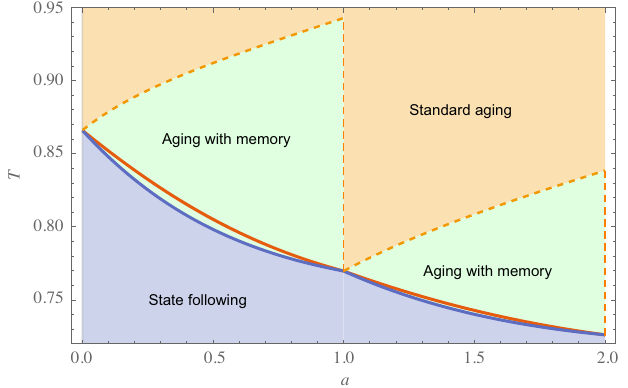
of Fig. 14. onset